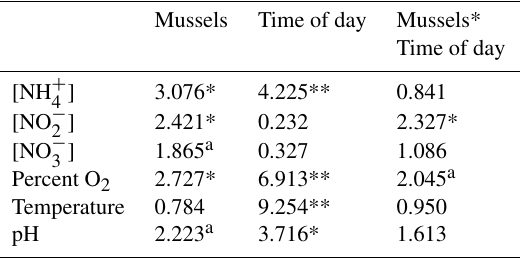
Table 2. A statistical summary of the role of mussels and day vs. night on resulting seawater chemistry and temperature